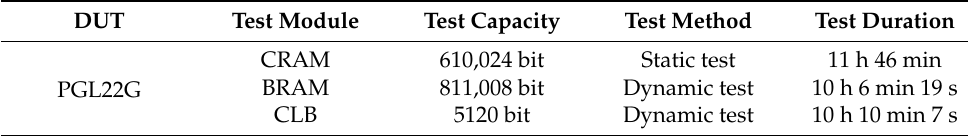
Table 3. Various test conditions for different modules of the device under test.